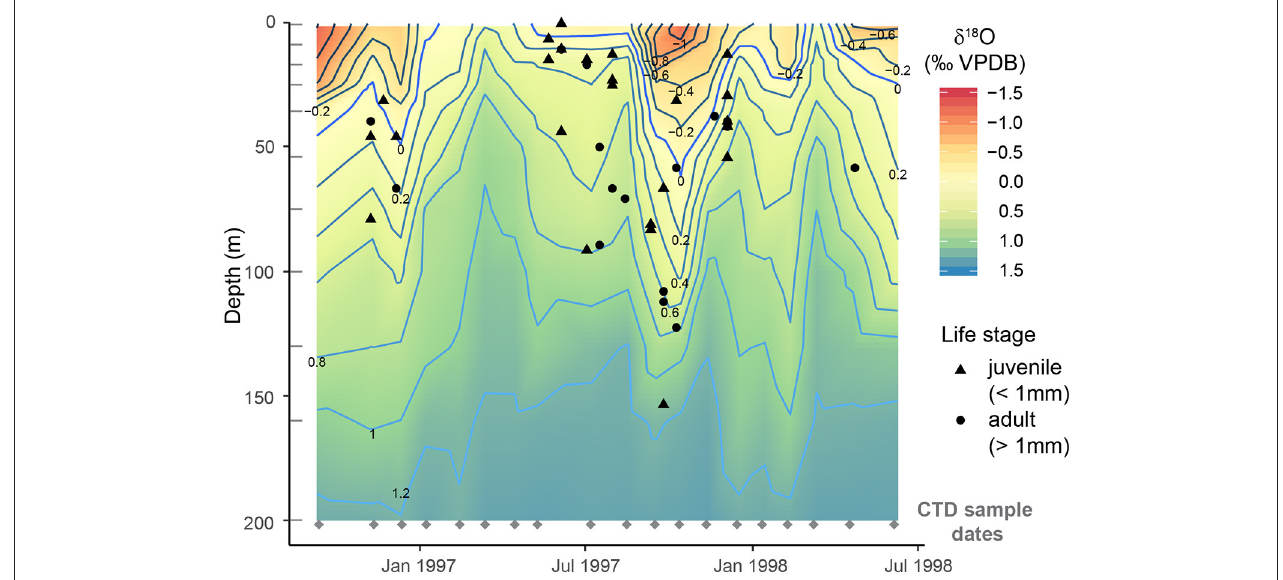
FIGURE 5 | Calcification depths of H. inflatus determined by comparing δ 18 O measurements of shells to δ 18 O of the water column calculated from CTD sampled bottle measurements of salinity using the LeGrande and Schmidt (2006) Tropical Atlantic calibration (two additional calibrations are presented in Supplementary Figure 4 ). The average calcification depth was 50.2 ± 33.5m (1s.d.). The shape of the point represents the life stage of the individual: juveniles ( < 1mm), adults > 1mm ( Lalli and Wells, 1978). There is not a significant correlation between calcification depth and shell size ( p = 0.090, R 2 = 0.067). CTD collection dates are marked by gray diamonds and CTD bottle depths are marked by gray lines; δ 18 O SW values between these points have been interpolated.